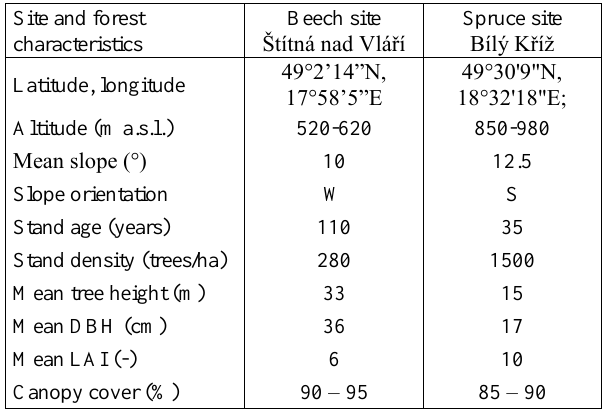
Table 1. Basic research site and forest stand characteristics. Stand parameters describe the forest status in the vegetation season of 2012. Abbreviations: DBH – diameter at the breast height, LAI – leaf area